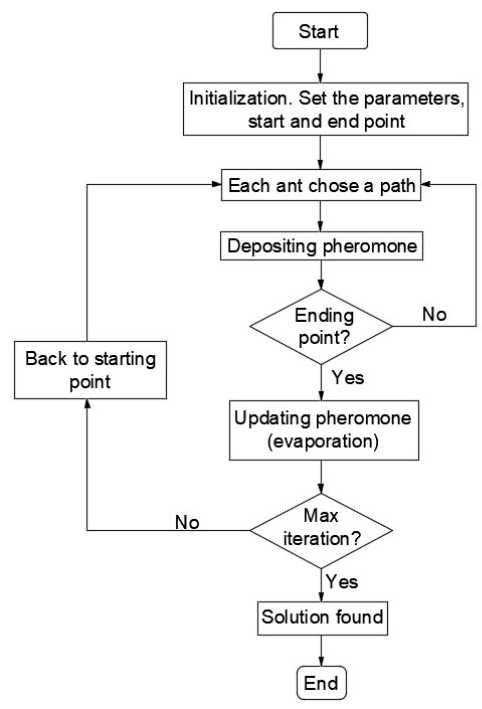
Figure 1. Flowchart of the ACO operation.